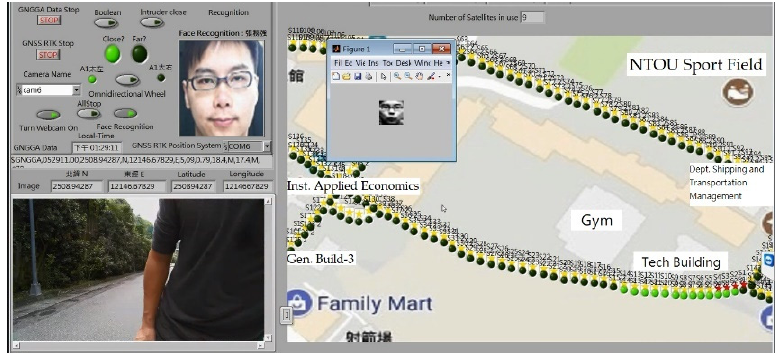
Figure 25. The robot displayed the identified person on the screen.